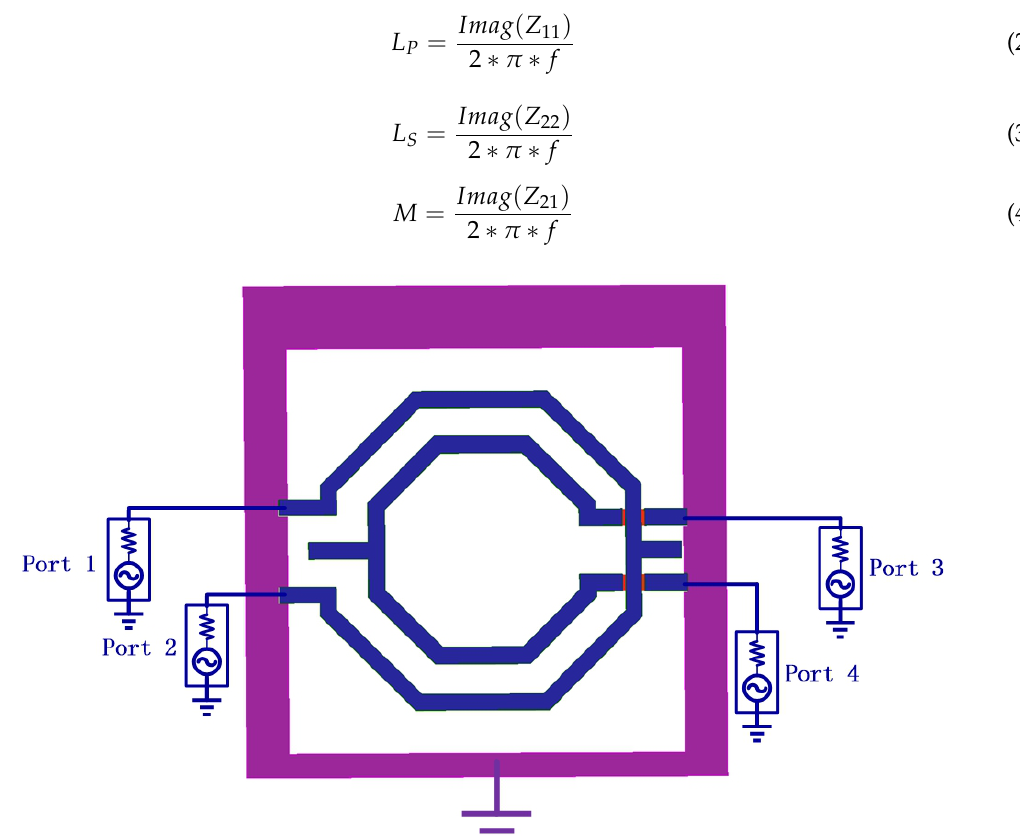
Figure 8. Based on S-parameter simulation of the testbench with two extraction ports, the extracted parameter results are given by Equations (2)–(4), where f is the central frequency of 10 GHz.